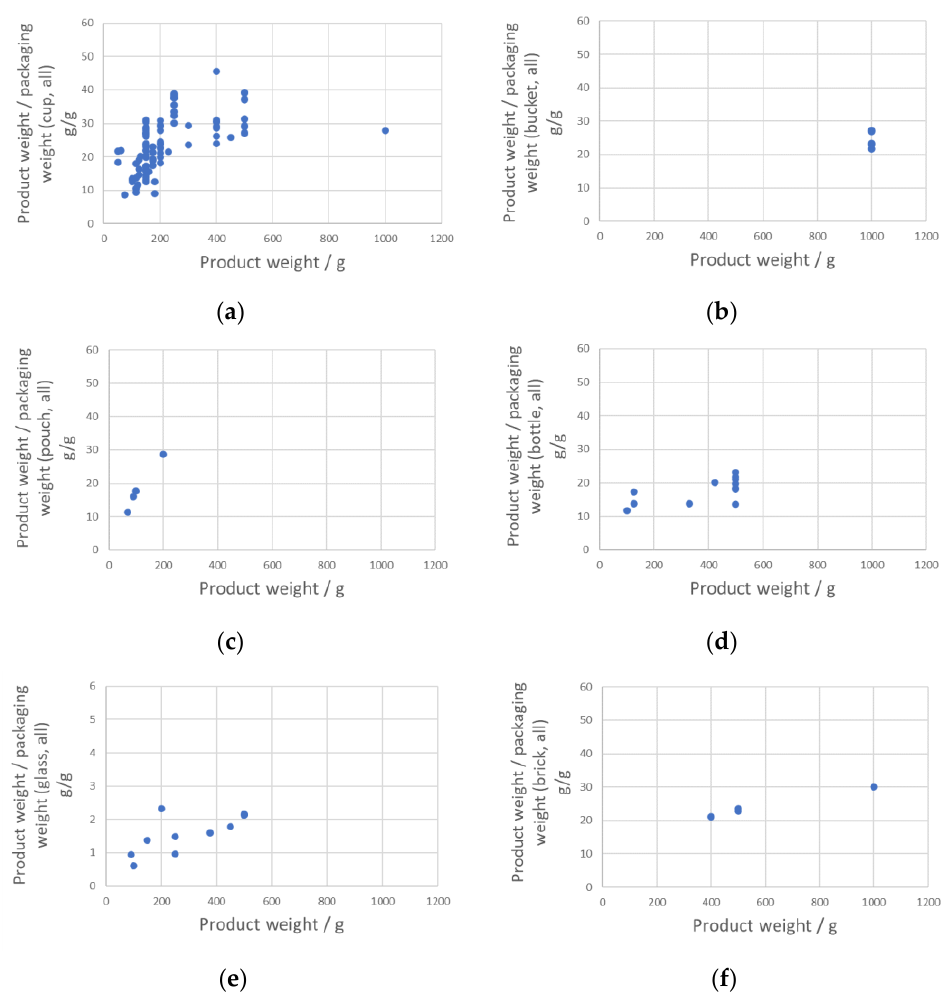
Figure 14. Packaging efficiencies over increasing product weights for different types of packaging, all packaging components are included; ( a ): cup, ( b ): bucket, ( c ): pouch, ( d ): plastic bottle, ( e ): glass packaging, ( f ): brick .